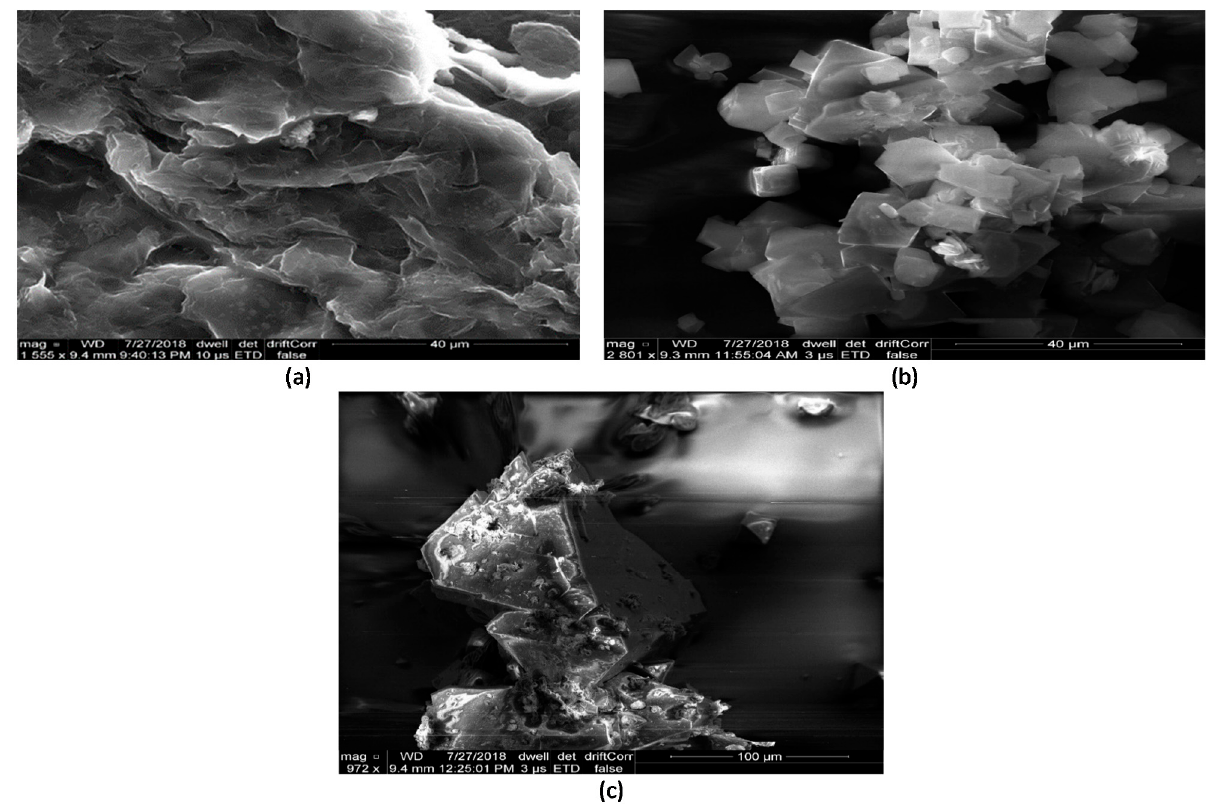
Figure 3. SEM images of powder samples ( a ) GO ( b ) HKUST-1 ( c ) HKUST-1 with 10% GO.